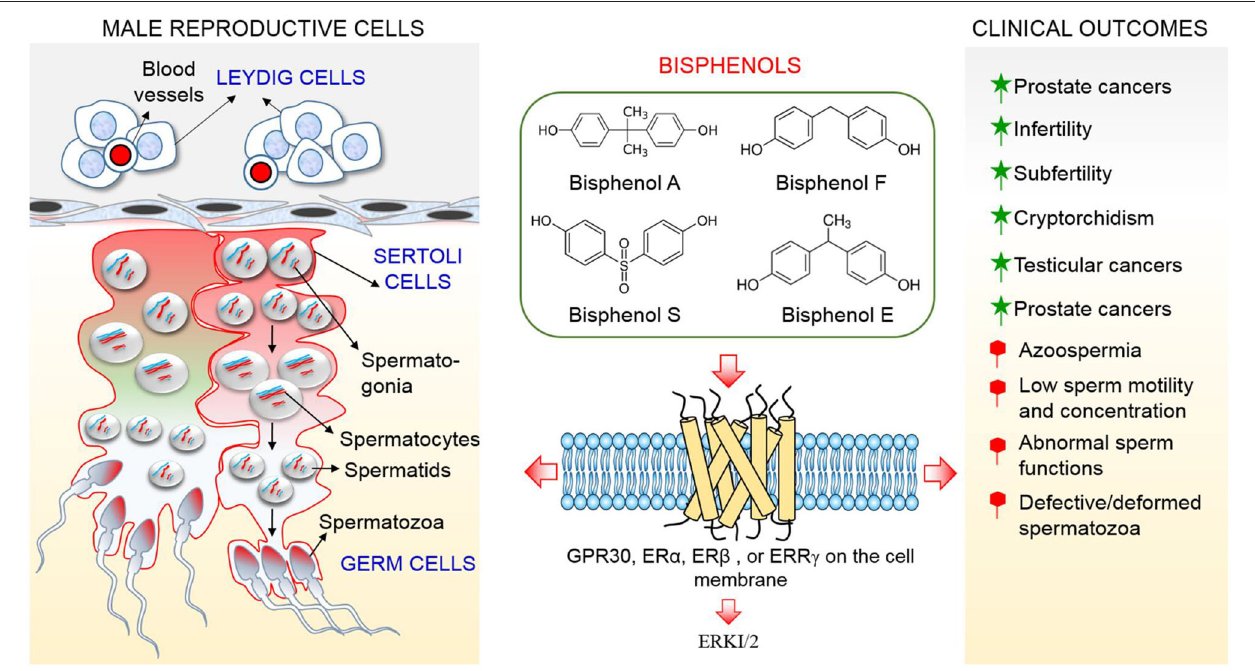
FIGURE 1 | Schematic representation of the action mechanism of bisphenols on testicular